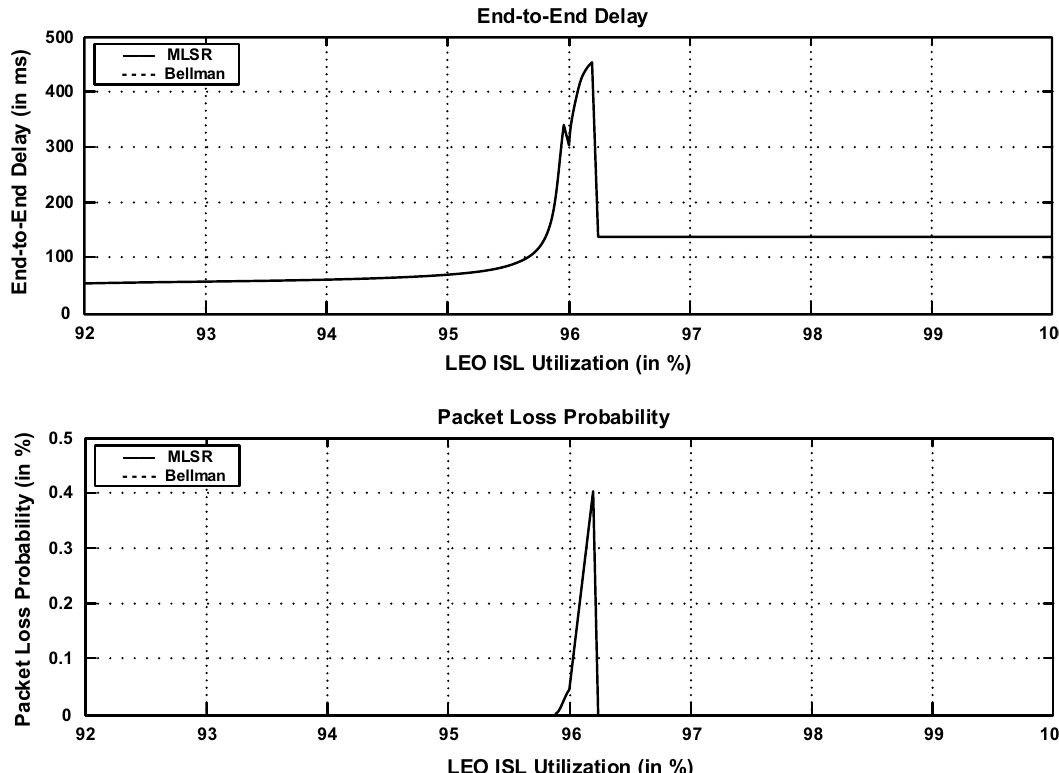
Figure 4. Delay and packet loss probability performance of the MLSR and shortest path routing algorithms. Because the performance of MLSR has the same performance as the shortest path algorithm, consequently, both curves are